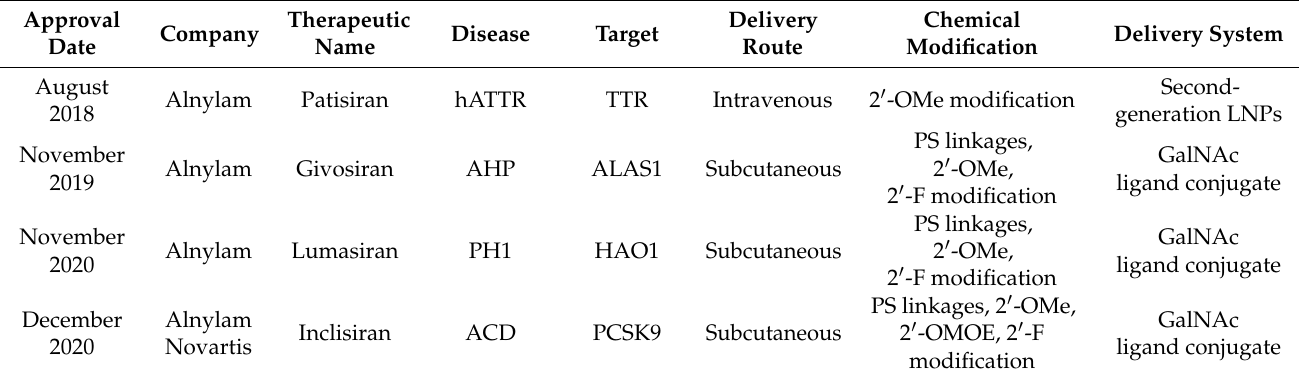
Table 6. FDA-approved siRNA